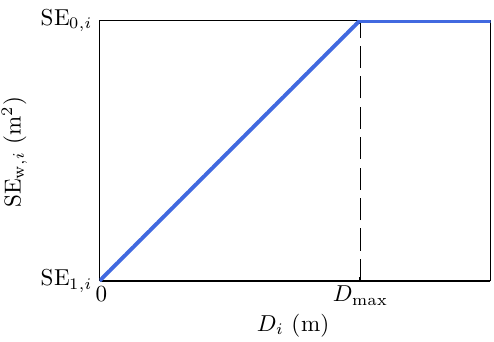
Fig. 2. Weighted squared error for the i th gridpoint SE w ,i , which is the sum of the local squared error after the warp SE 1 ,i and a penalty for misplacements δ( SE 0 ,i − SE 1 ,i ) with δ = D i /D max . The penalty ranges from 0 for D i → 0 to ( SE 0 ,i − SE 1 ,i ) for D i = D max , a user-defined maximum displacement length. For D i ≥ D max the full point-wise error applies and SE w ,i = SE 0 ,i .